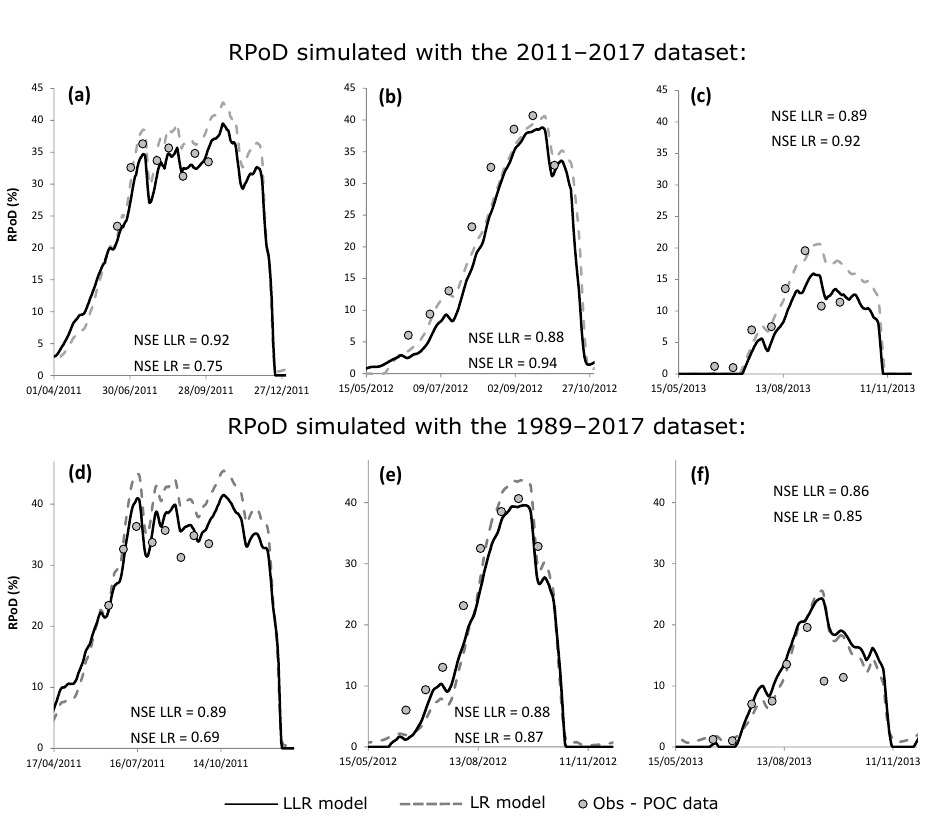
Figure 9. Comparison between observed proportion of drying RPoD POC and RPoD predicted by the LLR and LR models with the 2011–2017 dataset in (a) 2011, (b) 2012 and (c) 2013 and with the 1989–2017 dataset in (d) 2011, (e) 2012 and (f) 2013.